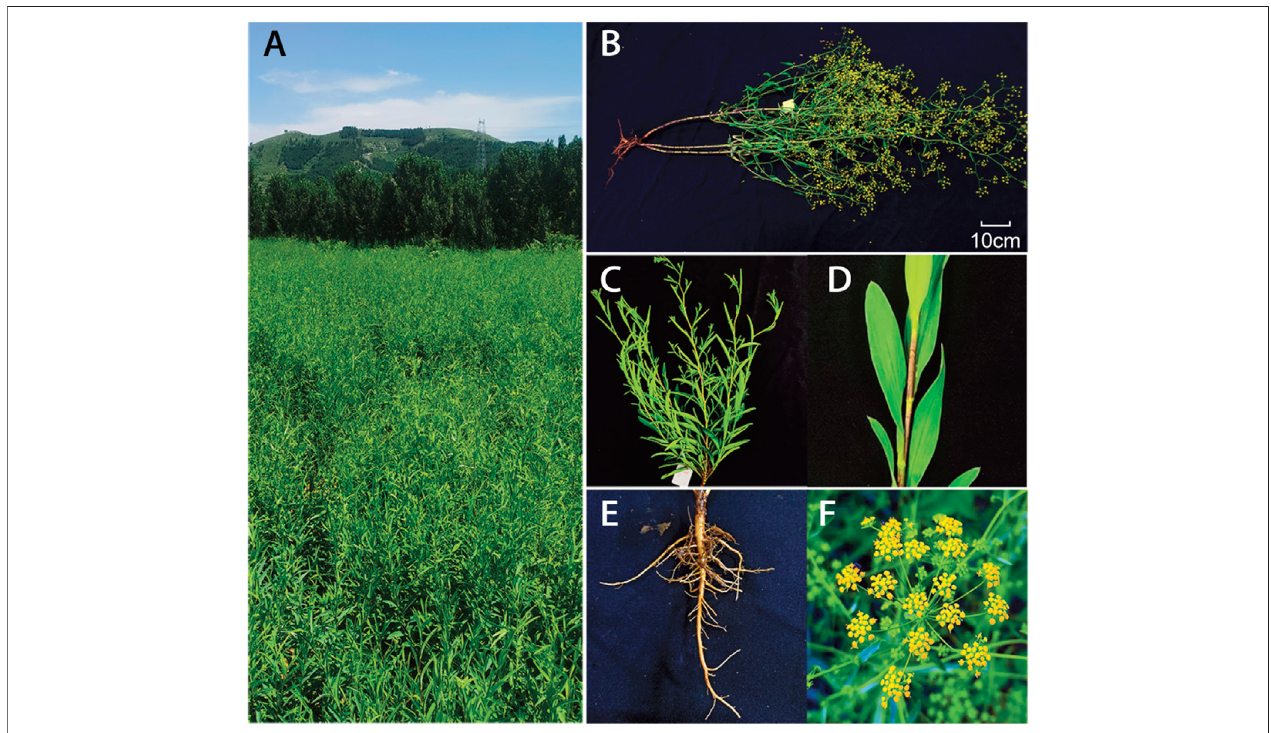
FIGURE 1 | Morphological characteristics ofthe B. chinense . Mature plants in (A) and (B) , The above-ground plant (C) and leaves in the stem (D) , root system (E) , and fl owers (F) are shown.